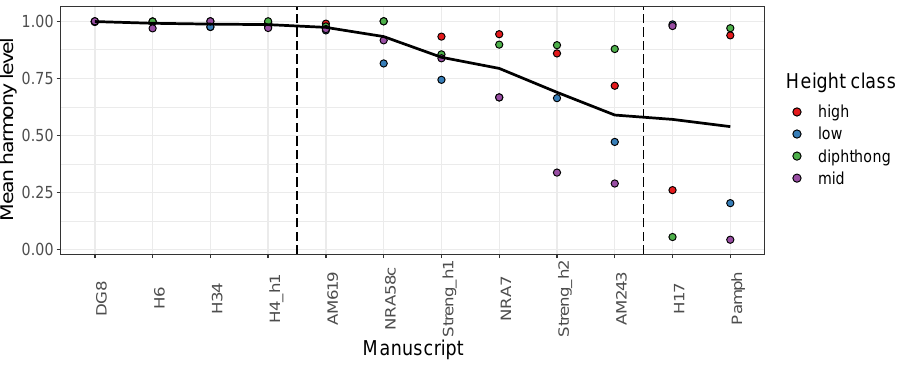
Figure 6: Mean harmony levels in historically harmonising contexts by manuscript height class in pre-decay, intermediary, and post-decay